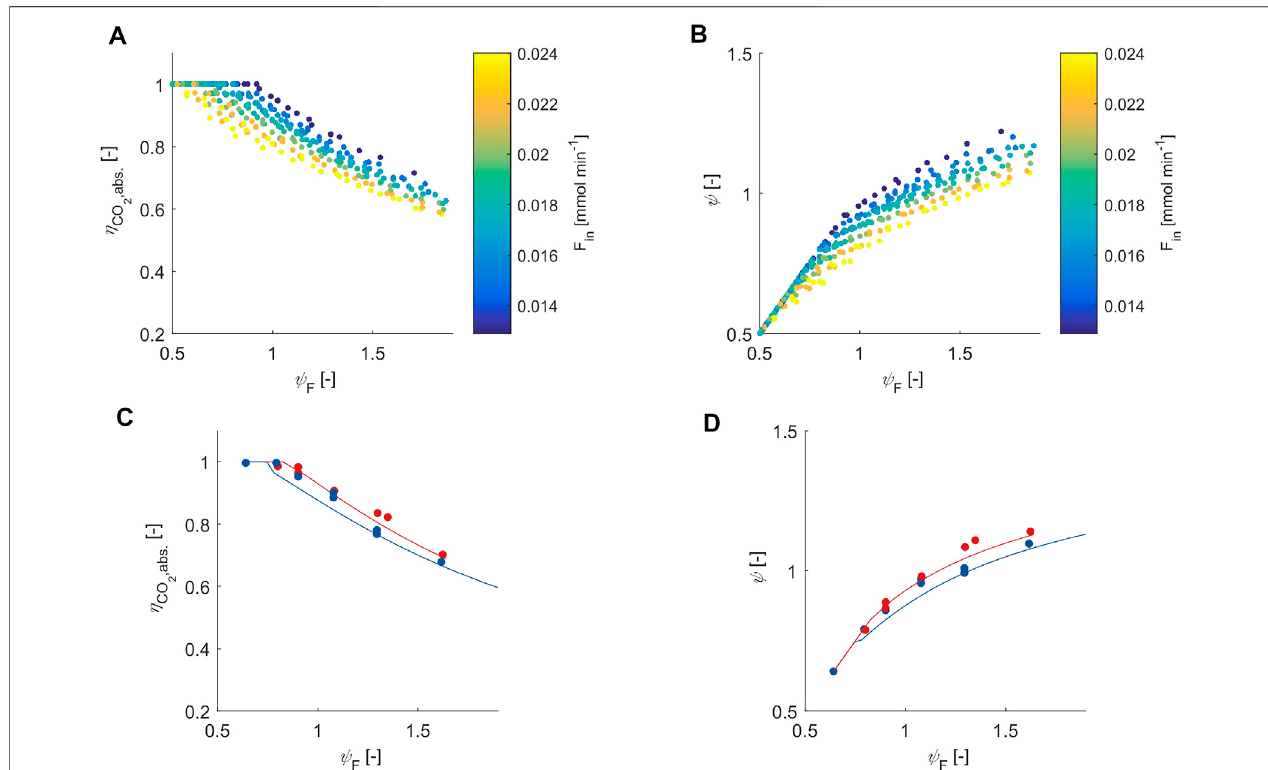
FIGURE 3 | The η CO and ψ are plotted as a function of ψ F . While subplot a and b visualize simulated operating points, subplot c and d combine experimental 2 , abs . results ( fi lled circles) with modelling results (solid lines). Red and blue data sets correspond to results obtained at 14.8 and 18.5 mmol min − 1 . (A) CO 2 absorption ef fi ciency. (B) ψ vs. ψ F . (C) CO 2 absorption ef fi ciency. (D) ψ vs. ψ F